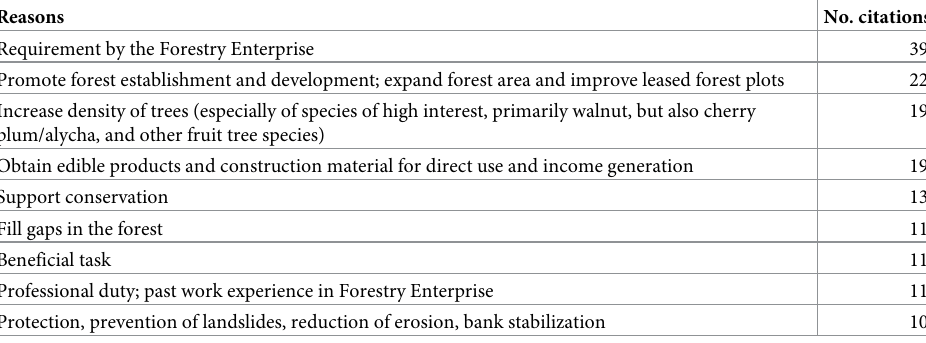
Table 9. Top-cited reasons for planting trees in the forest, all countries examined jointly. Reasons No. citations Requirement by the Forestry Enterprise 39